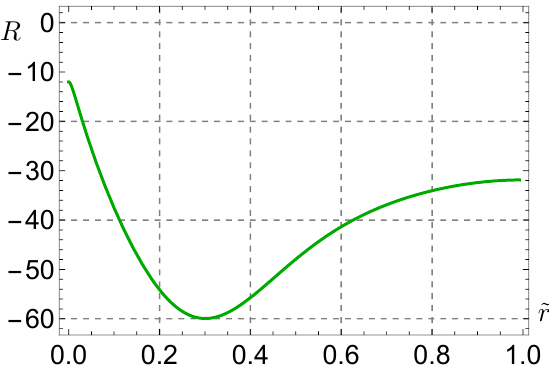
(cid:0)p p 3, (cid:14) = (cid:0) 1 = 3 and B=Q = 100.